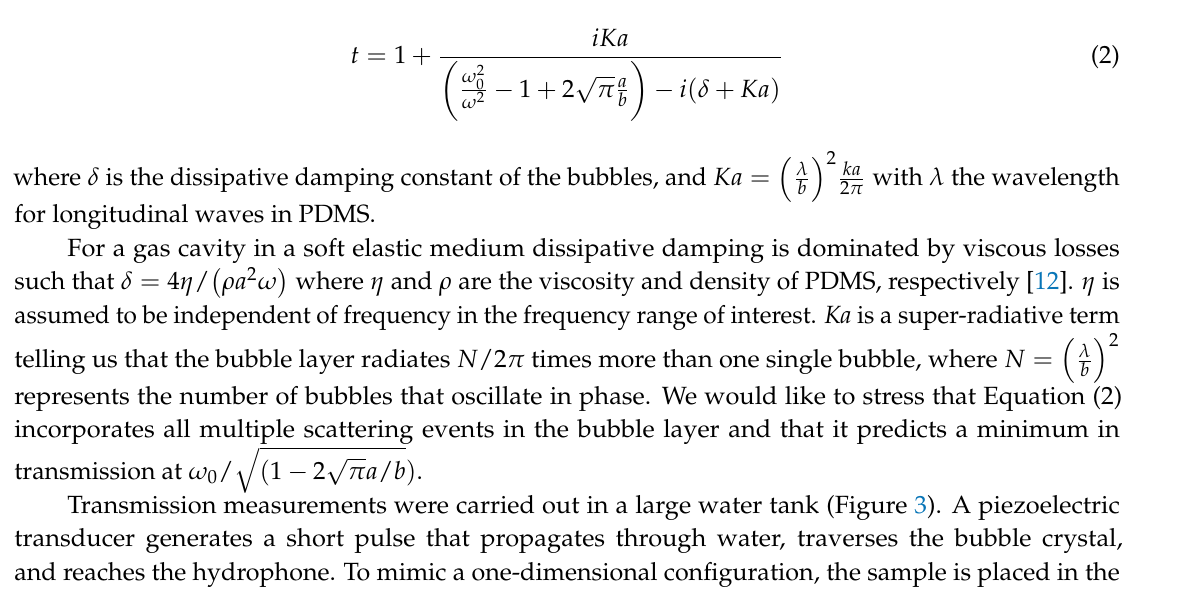
Figure 2. Practical realization of a monolayer bubble crystal in PDMS: ( a ) The monomer-crosslinking mixture is poured onto a mold; ( b ) After sealing, the sample is cured for 45 min at 65 °C. The operation is repeated with a second, non-textured mold; ( c ) After curing, the polymer becomes solid and can be unmolded; ( d ) The two blocks of PDMS are joined so that the bubbles are isolated from the outside. Then, the transmission coefficient of such a one-layer crystal is predicted to be [6]: